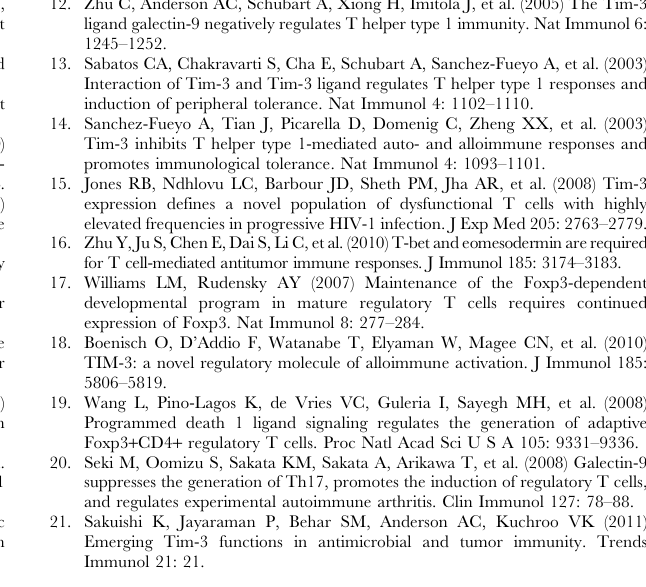
Figure S1 TIM-3 expression by flow cytometry. Tumor infiltrating lymphocytes (TILs) were harvested from lung cancer tissues, adjacent normal tissues, and peripheral blood monouclear cells (PBMCs) from whole blood of patients. Cells were then stained for CD4 and TIM-3 or CD4 plus a control IgG antibody. Cells in the lymphocyte gate were further analyzed for CD4 and TIM-3 expression. Figure S2 Tim-3 expression in native Tregs and its dependence on Foxp3. NCBI GEO profile database was queried for Tim-3 expression in Tregs. One result showed that Tim-3 is down-regulated in Foxp3 deficient native Tregs as shown here. DataSet Record